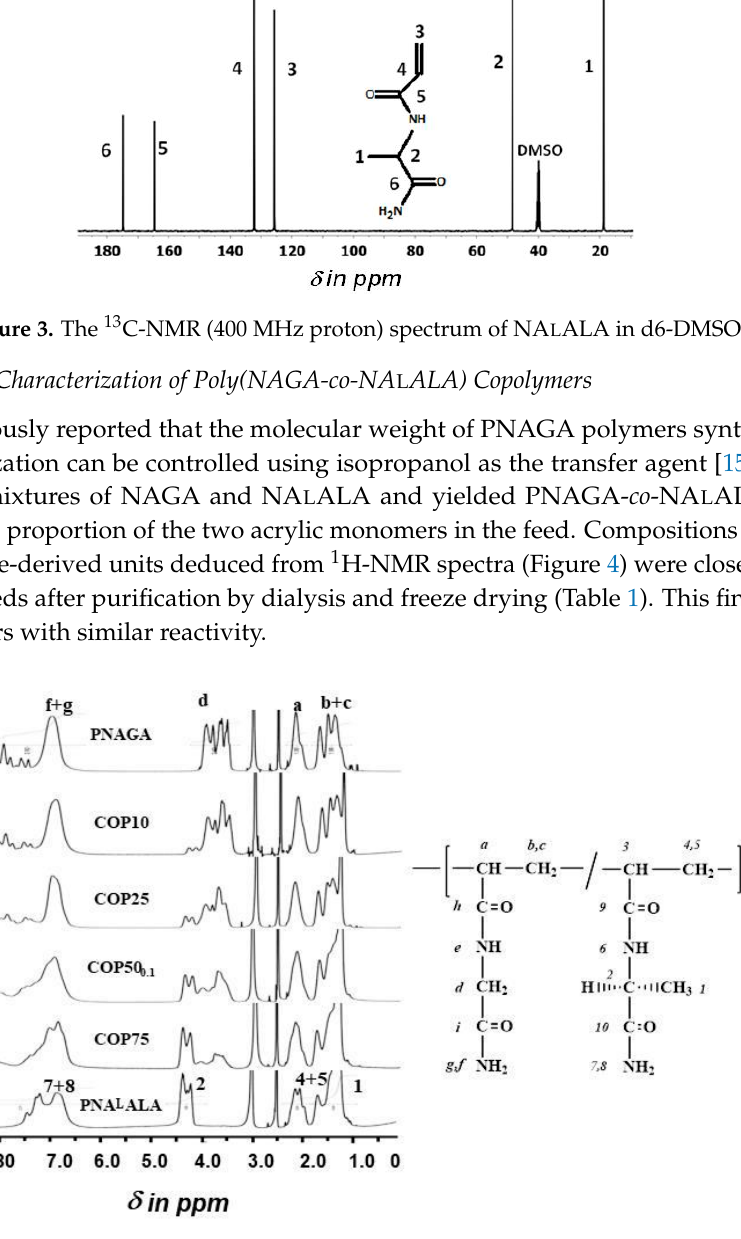
Figure 2. Comparison of the 400 MHz 1 H-NMR spectra of NAGA ( top ) and NA L ALA ( bottom ) in d6- DMSO.